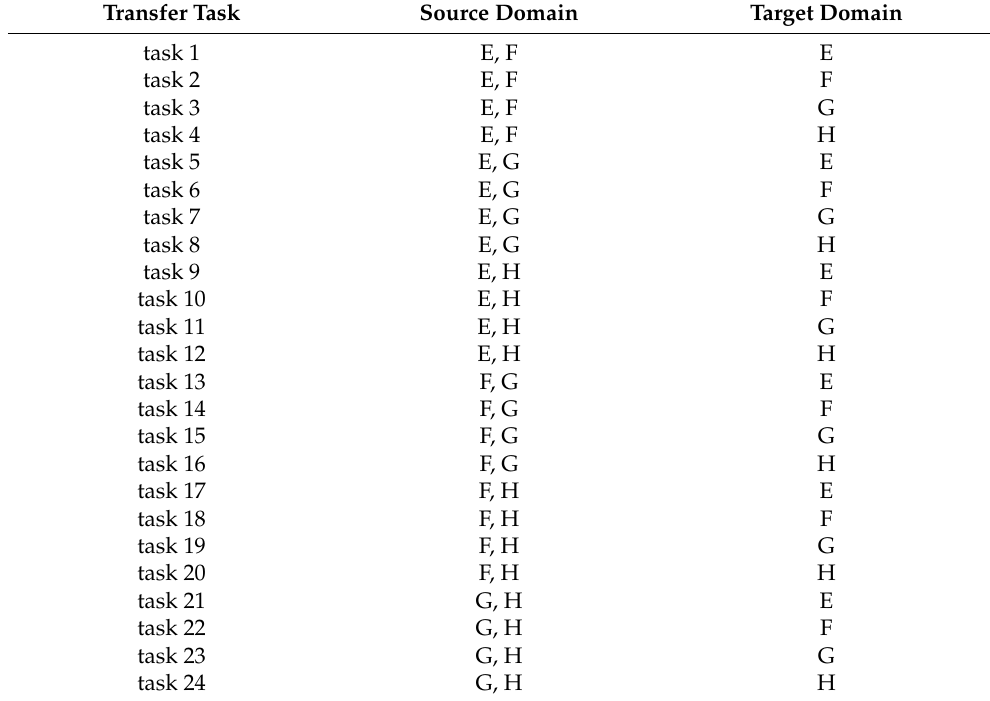
Table 4. DCNG transfer tasks on KAT data